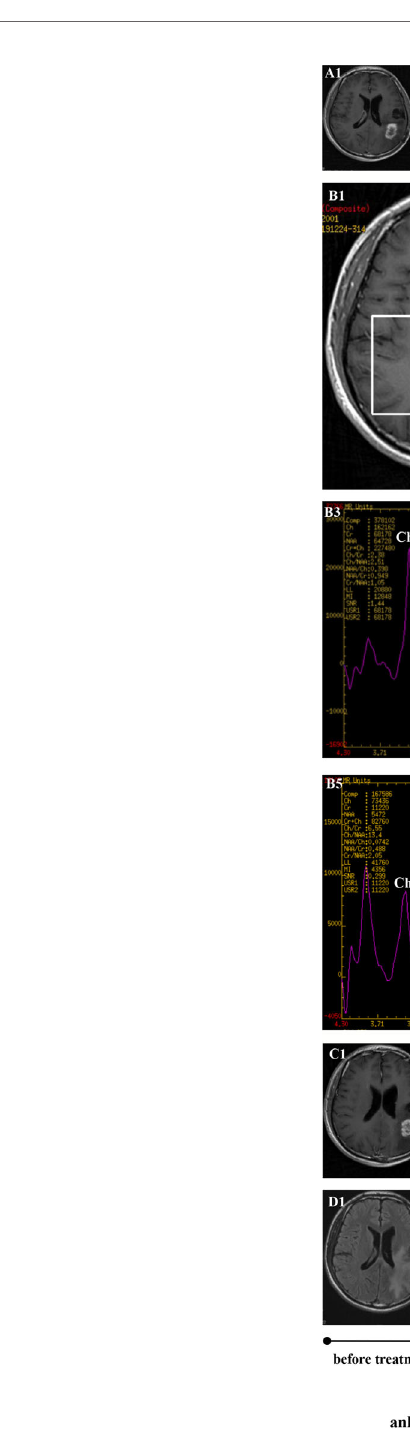
Frontiers in Oncology |